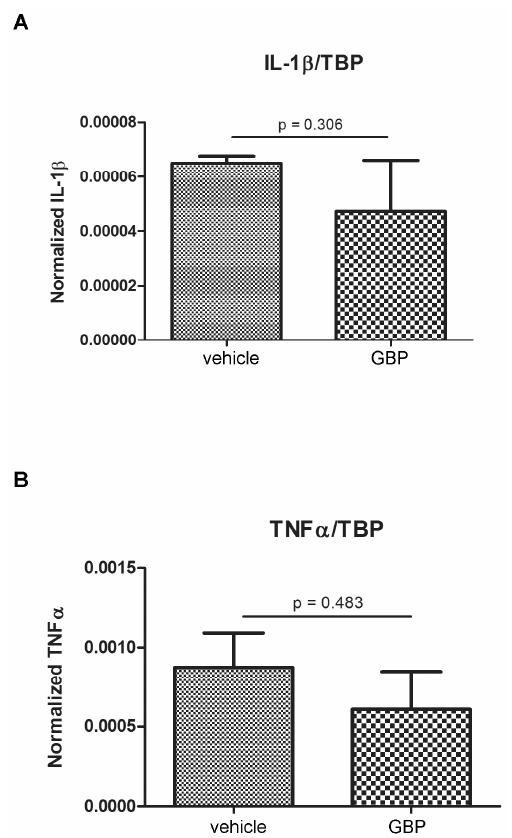
Figure 8. Gabapentin treatment does not significantly reduce reactive cytokine expression in SE animals. ( A , B ) Quantitative real time RT-PCR studies of IL-1 β and TNF α mRNA expression in the hippocampus of vehicle- or GBP-treated SE animals. Data are relative to the housekeeping gene TBP and are represented as mean ± SEM of 3 determinations. Statistical significance was analyzed using the two tailed Student- t -test.